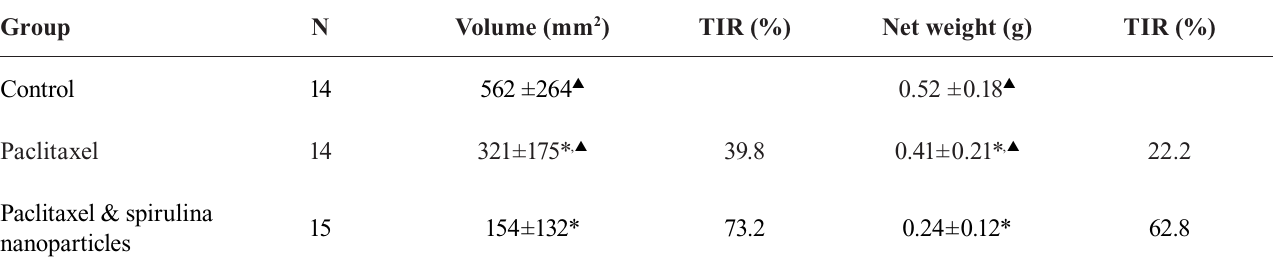
TABLE II - Median and Mean survival time